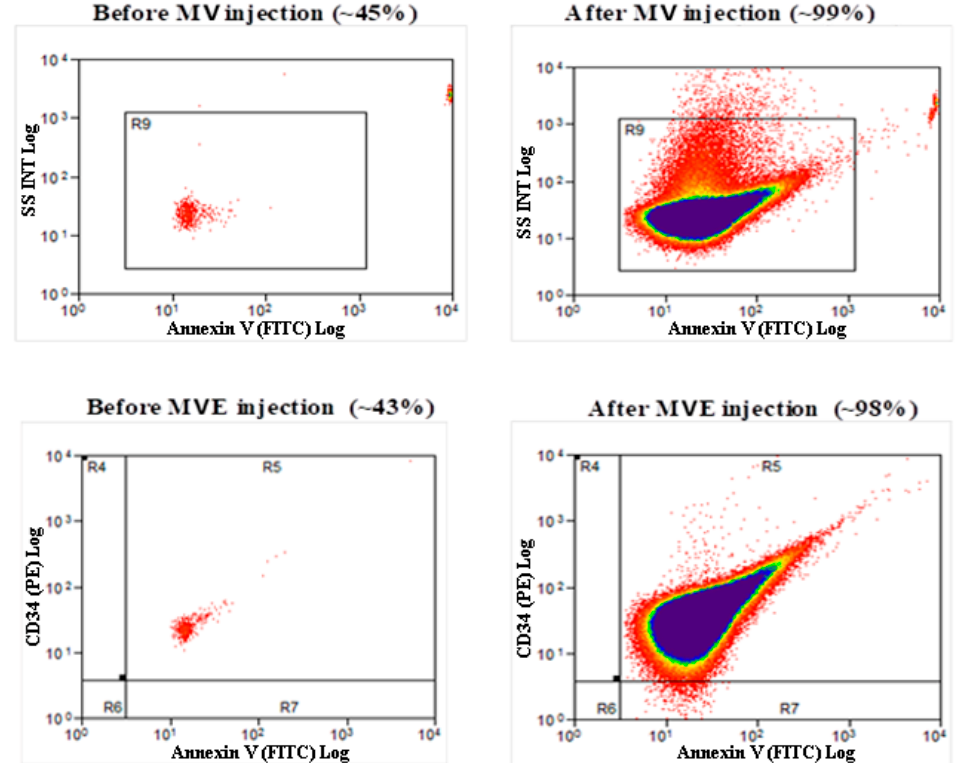
Figure 3. Representative flow cytometric measurements of MV / MVE levels before and after retro-orbital sinus injection containing 1 × 10 5 MVs or MVEs to HH group ( n = 3 individual animals per group); MVs were positive for AnnexinV-FITC, and MVEs were double positive for AnnexinV-FITC and